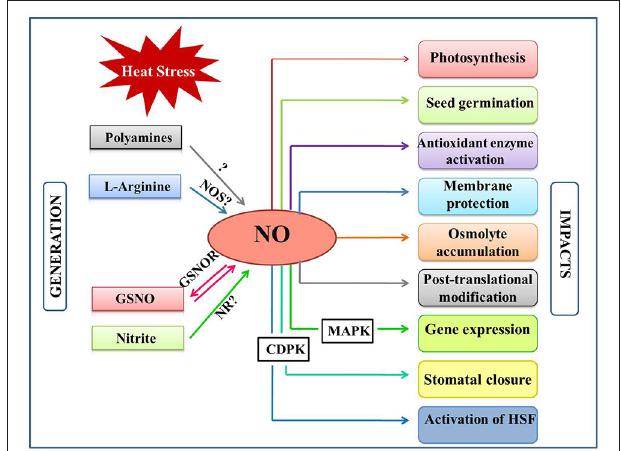
FIGURE 1 | Overview of the NO generation and impacts in plants under heat stress. Heat stress induce NO accumulation majorly by a non-identified NOS-pathway, nitrite-dependent pathway. NO can also be generated by polyamines and by reversible regulation of S-nitrosoglutathione (GSNO) by the action of GSNO reductase (GSNOR). Besides, NO levels are also influenced by various plant hormones under heat stress. This figure also indicates the major plant functions that are mediated by NO-generation/signaling when exposed to heat stress. CDPK, Calcium dependent protein kinase; GSNO, s-ntrosoglutathione; GSNOR, GSNO reductase; HSFs, Heat shock factors; MAPK, mitogen activated protein kinase; NO, nitric oxide; NOS, Nitric oxide synthase; NR,